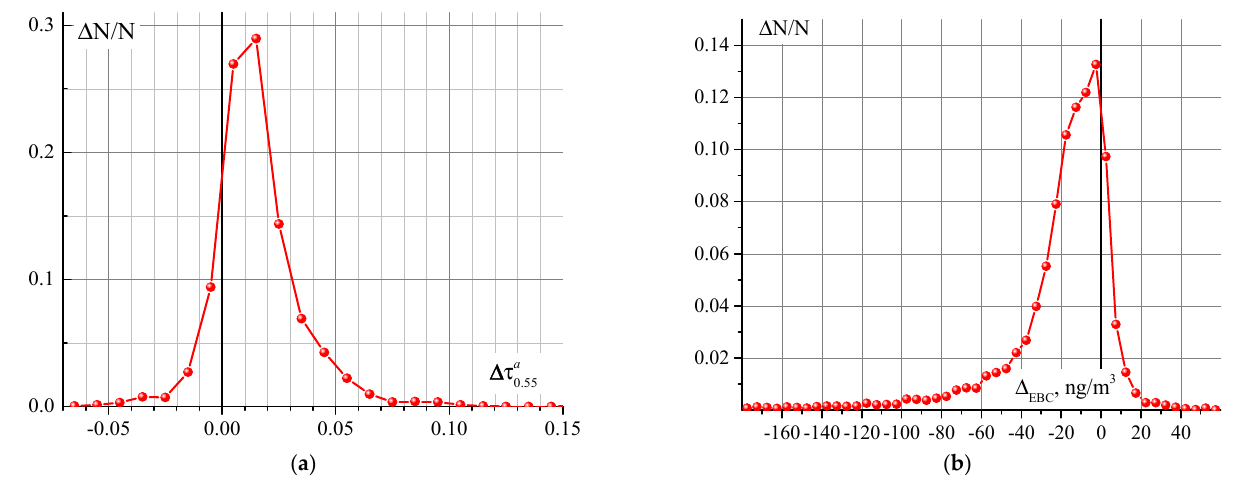
Figure 7. Frequency histogram of the differences between the model (MERRA-2) and experimental (RV) values of AOD and EBC ( ∆ τ and ∆ EBC ). ( a ) ∆ τ a 0.55 and ( b ) ∆ EBC , ng/m 3